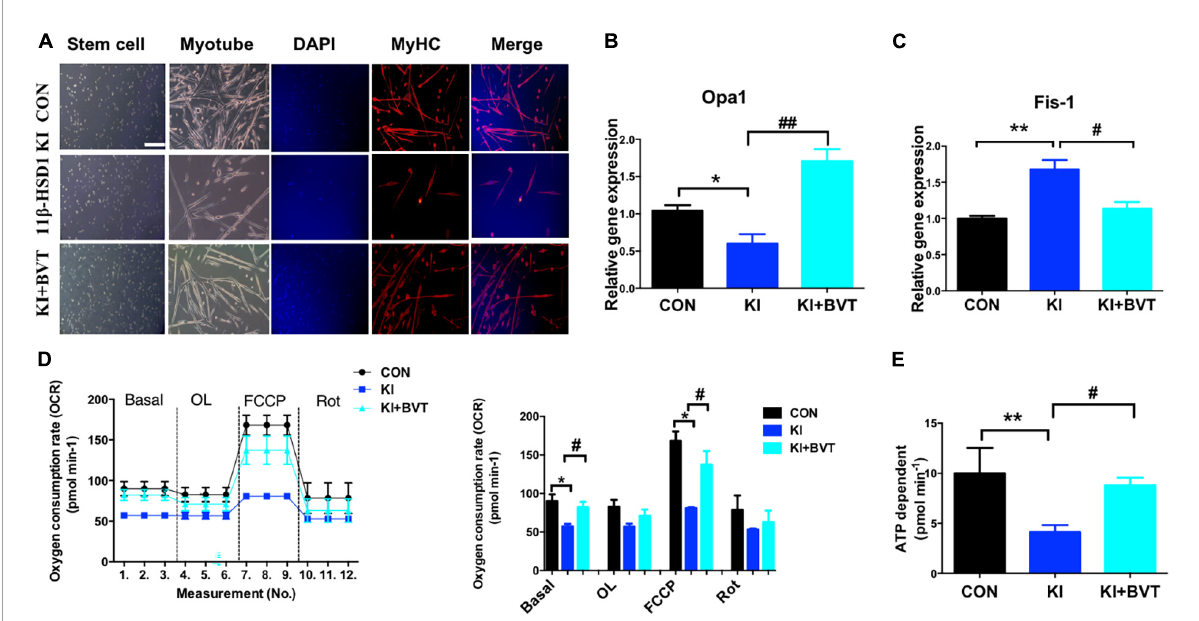
FIGURE6 11 β -HSD1 inhibitor BVT.2733 improved mitochondrial function in mouse muscle stem cells (MuSCs). (A) Representative immunofluorescent staining images of cultured MuSCs at 3 days of differentiation from 11 β -HSD1 KI mice and 11 β -HSD1 inhibitor BVT.2733-treated KI mice and control mice at 2 months of age. Red indicates MyHC staining; DAPI indicates nuclei. Scale bars, 200 µ m. (B) mRNA levels of the mitochondrial fusion gene Opa1 in MuSCs from 11 β -HSD1 KI mice and 11 β -HSD1 inhibitor BVT.2733-treated KI mice and control mice. (C) mRNA levels of the mitochondrial cleavage gene Fis-1 in MuSCs. (D) Oxygen consumption rate measurement during the differentiation of MuSCs from 2-month-old mice. (E) ATP synthesis rate measurement during the differentiation of MuSCs from 2-month-old mice. * p < 0.05, ** p < 0.01; # p < 0.01, ## p < 0.01. *KI mice compared with control; #KI + BVT compared with